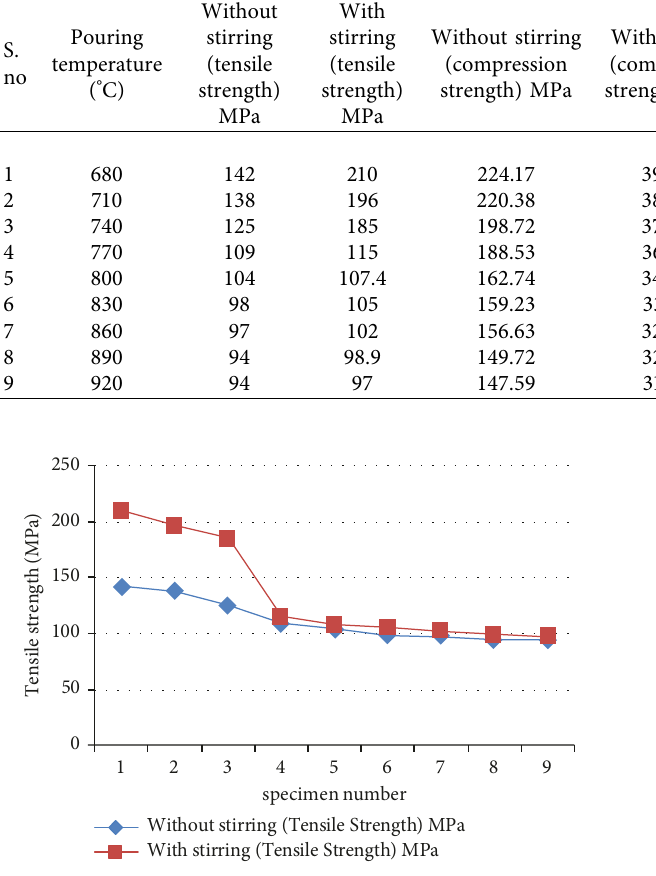
Figure 24: Graph for tensile strength for different specimens.